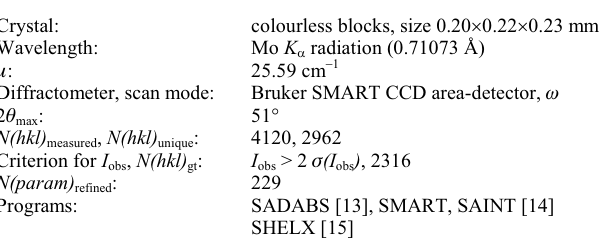
Table 1. Data collection and handling.